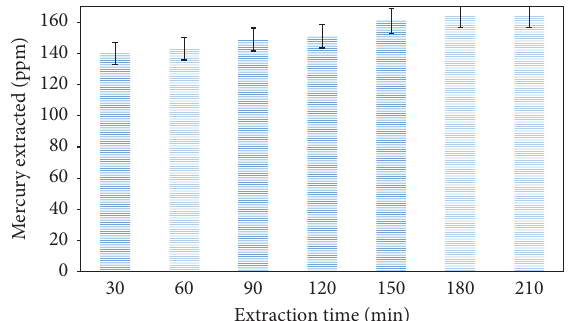
Figure 7: Concentration of extracted mercury via time of ex- traction at the concentration of 3g/l (rpm � 200, T � 25 °